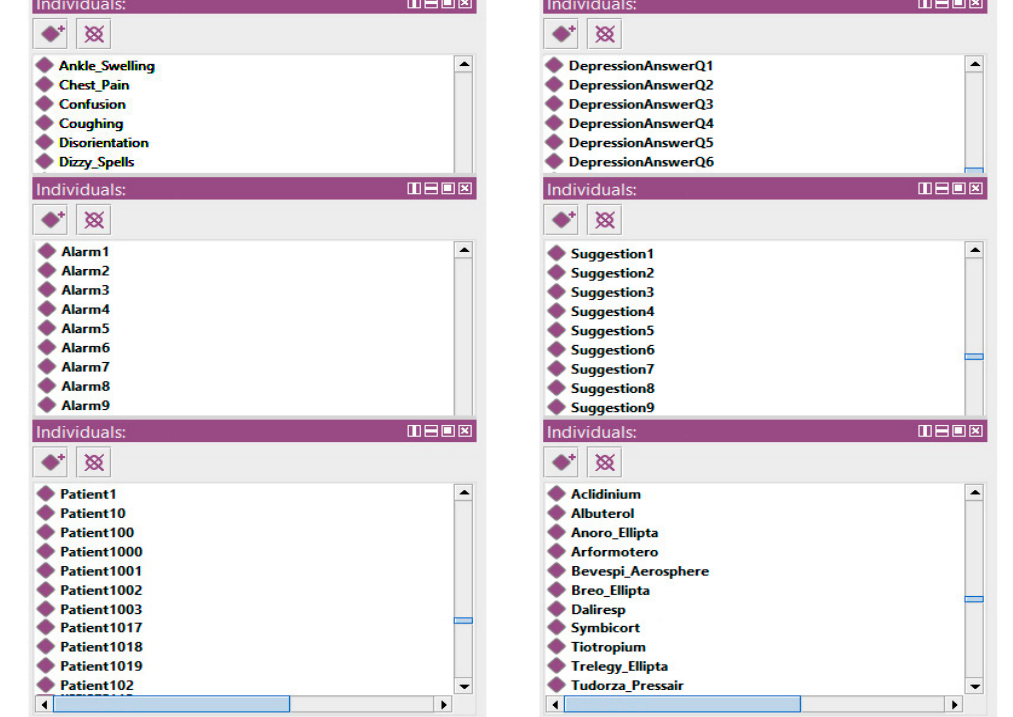
Figure 15. Examples of instances in the ontology.